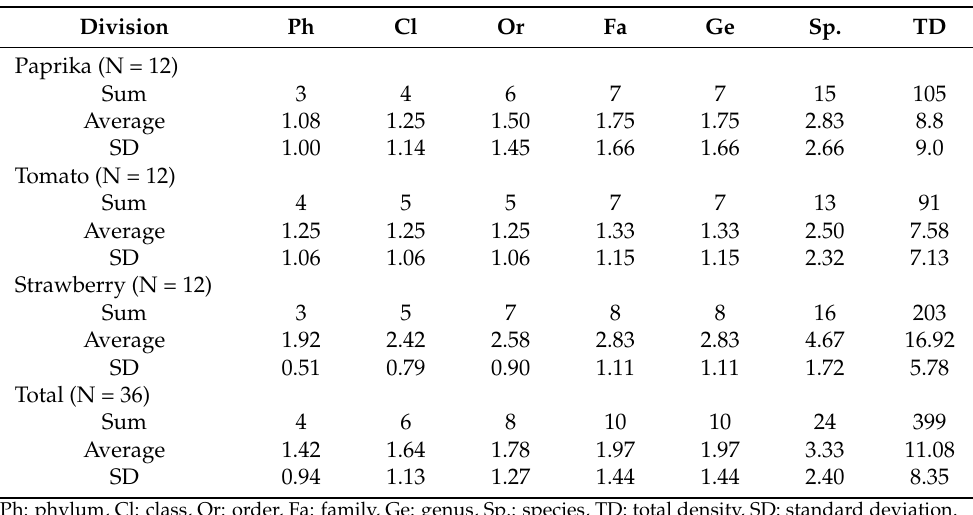
Table 2. Fungi detected according to the type of crop.